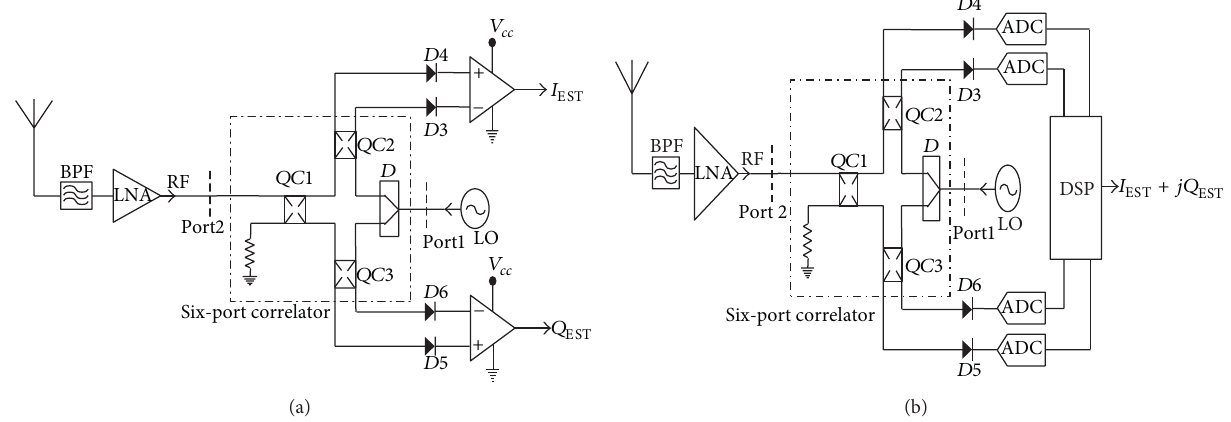
Figure 2: (a) SPR architecture using quasi-ideal component. (b) SPR architecture with DSP